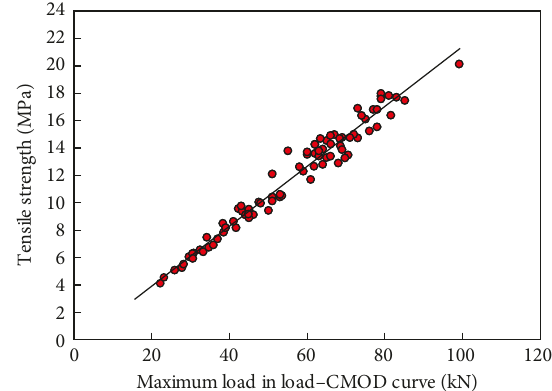
Figure 8: Comparison of the maximum loads in the load-CMOD curve with the tensile